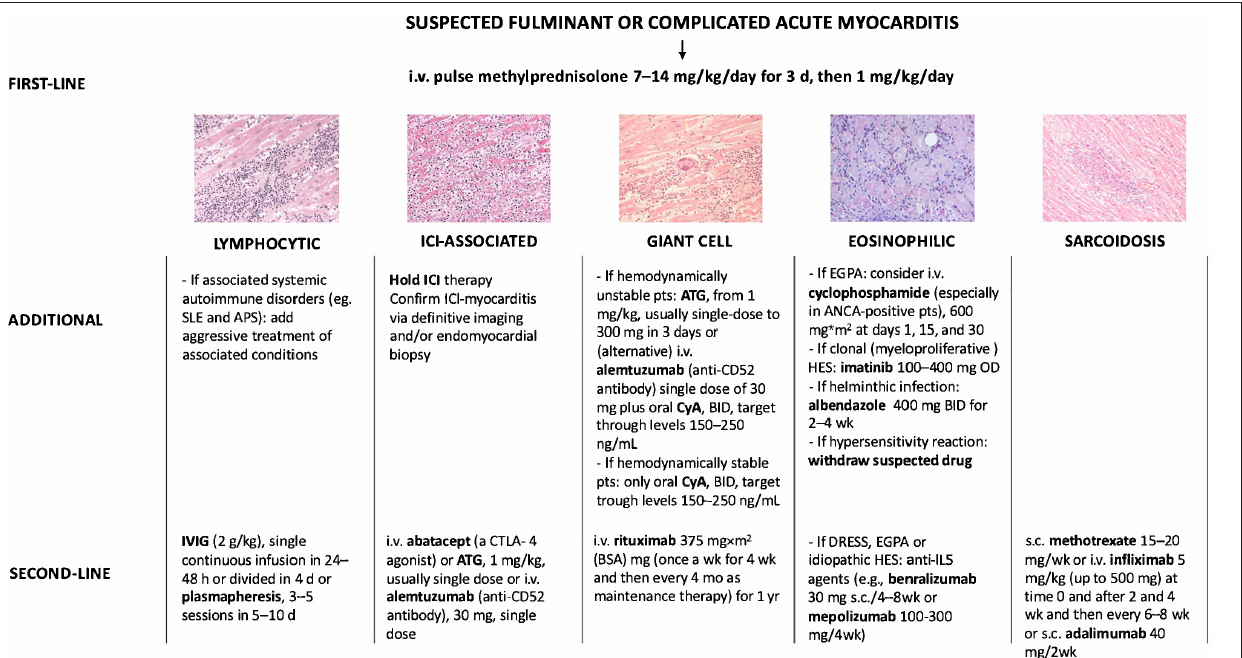
FIGURE 1 | Immunosuppressive treatment strategies used for fulminant myocarditis or complicated acute myocarditis not supported by evidence from clinical trials but based on published case reports/series. i.v., intravenous; d, day; IVIG, intravenous immunoglobulin; h, hour; SLE, systemic lupus erythematosus; APS, antiphospholipid syndrome; ICI, immune checkpoint inhibitor; pts, patients; ATG, anti-thymocyte globulin; wk, week; CyA, cyclosporine; mo, month; EGPA, eosinophilic granulomatosis with polyangiitis; ANCA, antineutrophil cytoplasmatic antibodies; DRESS, drug reaction with eosinophilia asn dystemic symptoms; HES, hypereosinophilic syndrome; s.c., subcutaneous. Adapted from Ammirati et al. (